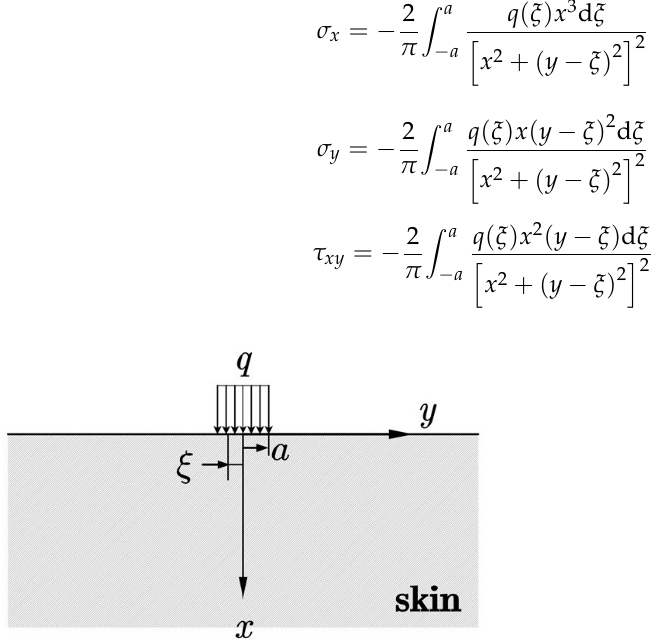
Figure 2. The mechanical model of compression on the skin.